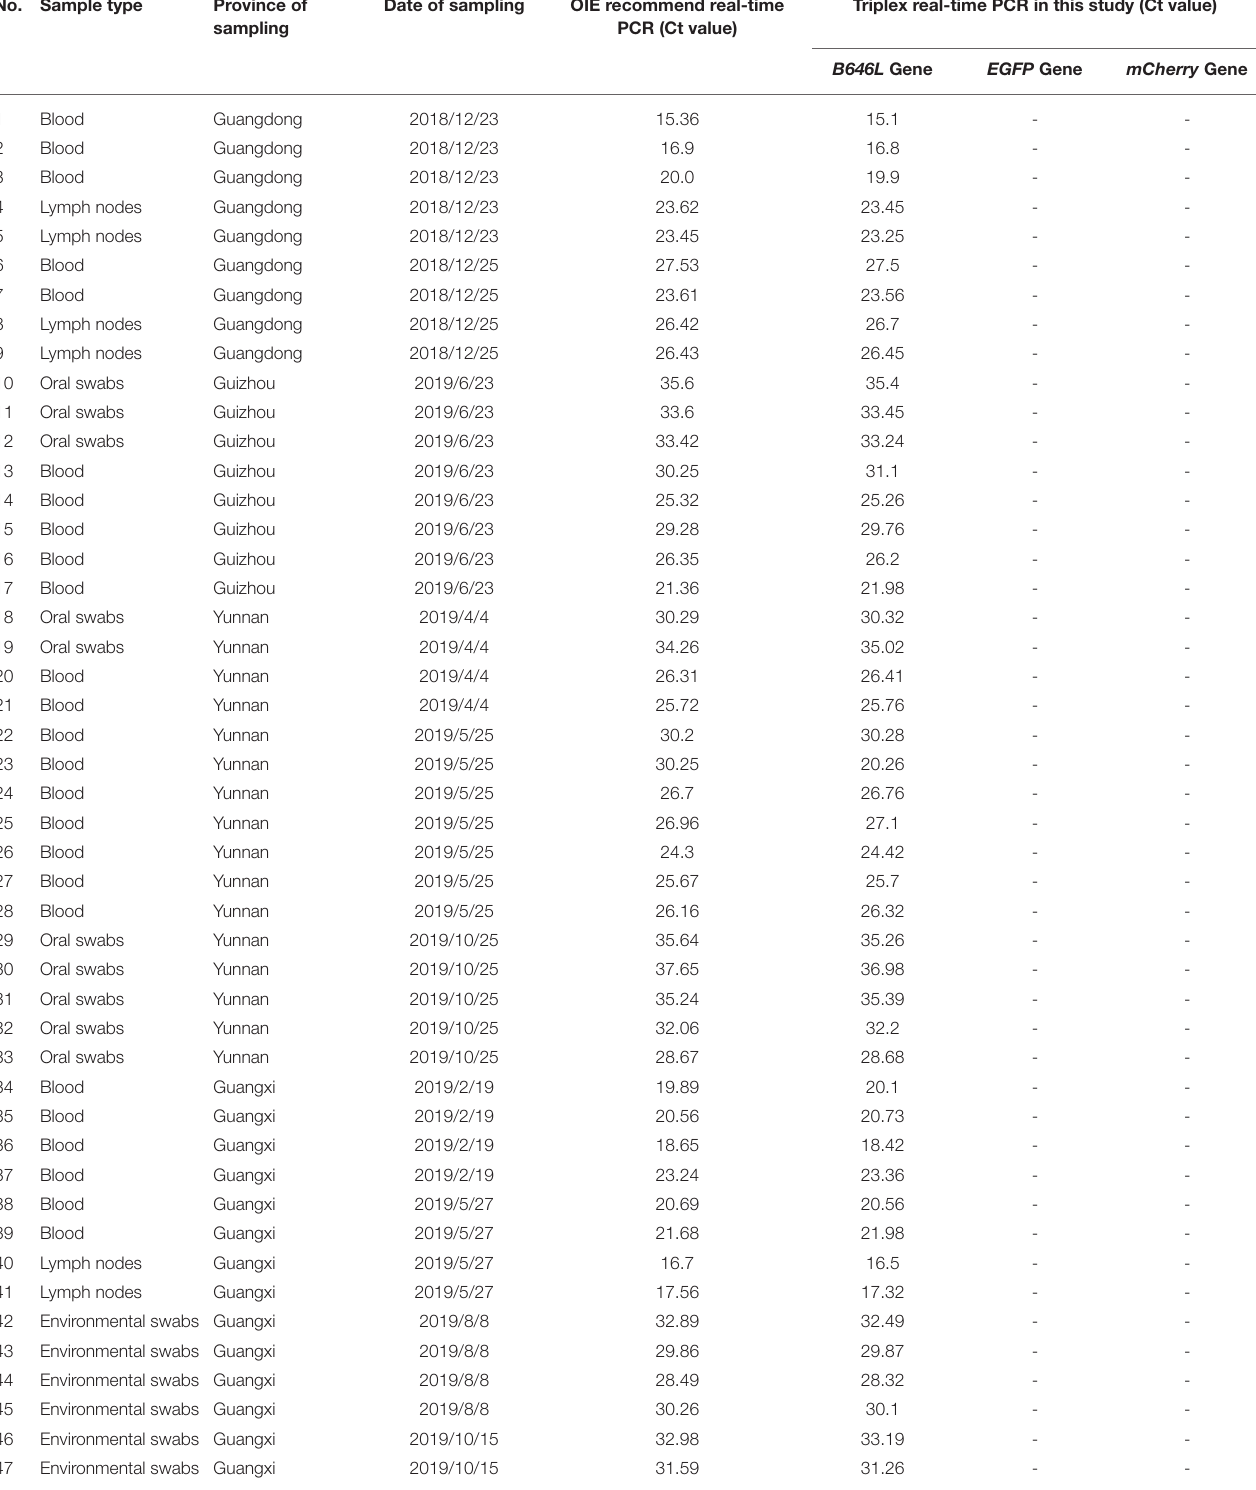
TABLE 2 | Identification of the 67 ASFV clinical positive samples was performed using the ASFV real-time PCR method. No. Sample type